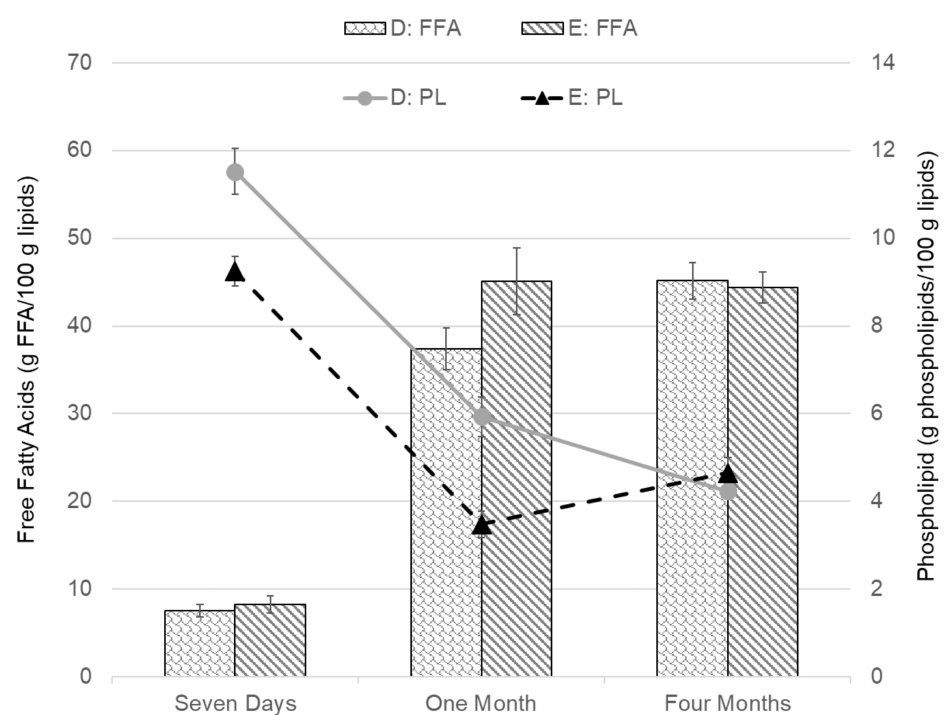
Figure 5. Comparison of Free Fatty Acids (FFA) and Phospholipids (PL) results for Groups D and E. The error bars show the standard error of the mean values ( µ ± σ µ